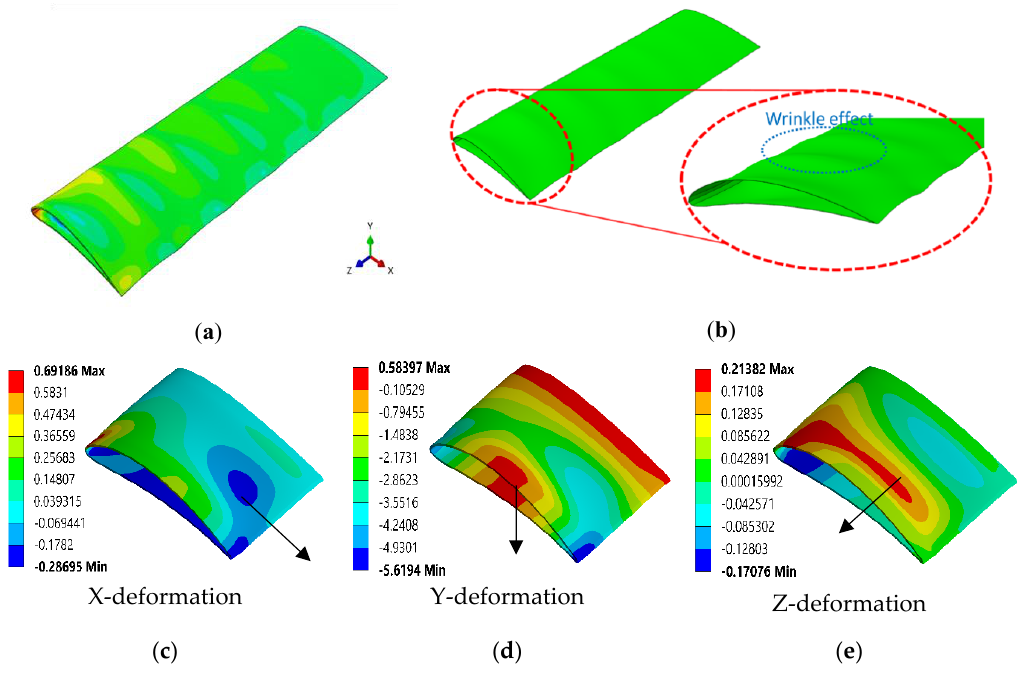
Figure 6. Wing model bulk material out-of-plane deformation for 1% camber rate. ( a ) entire wing’s out-of-plane deformation, ( b ) zoomed wing-tip deformation, ( c ) X-axial deformation, ( d ) Y-axial deformation, and ( e ) Z-axial deformation respectively.